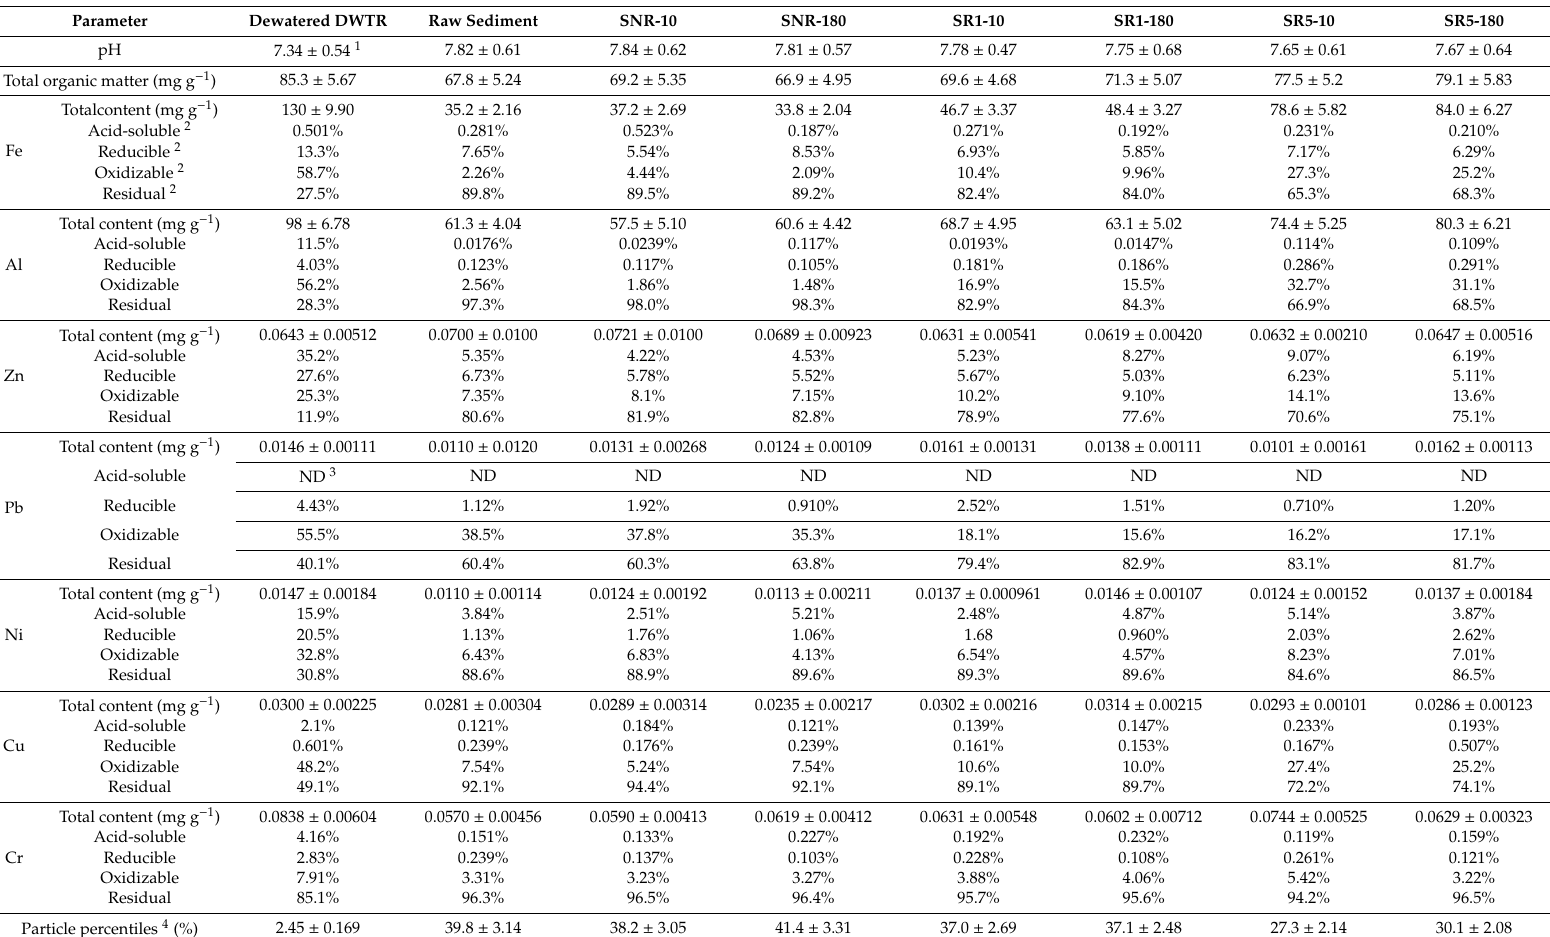
Table 2. The properties of drinking water treatment residue (DWTR) and